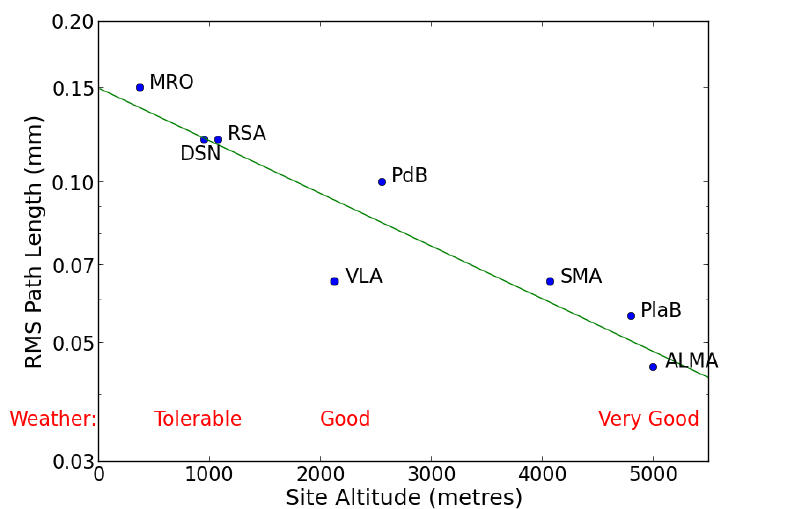
Figure 8. Implications of FPT benefits on antenna site selection. The plot follows that of Figure 13.18 using the data in Table 13.4 in Thompson et al. [22], showing the correlation between site altitude and empirical RMS pathlength measurements. Overplotted, in red , is the correspondence between altitudes and the simulation weather conditions explored in this paper, based on the RMS pathlength values from atmospheric models. The use of FPT calibration relaxes the requirements for suitable sites for (sub)mm-VLBI observations and will allow Good sites, i.e., above 2000 m, of which there are many